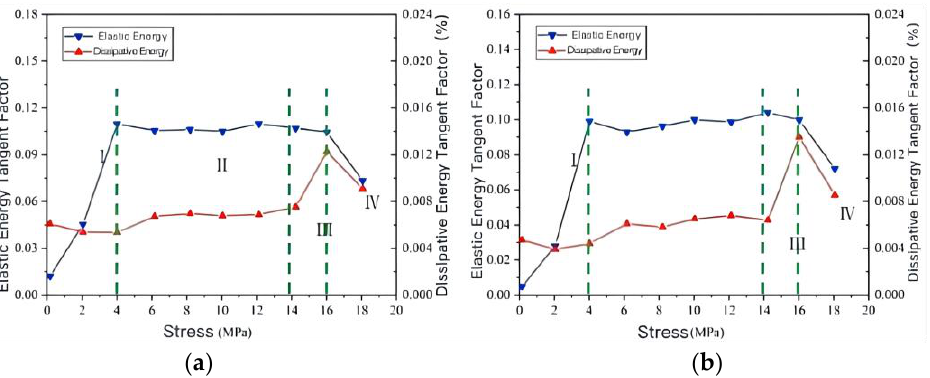
Figure 9. The energy tangent factor during grading cyclic loading/unloading. ( a ) Elastic energy tangent factor and dissipative energy tangent factor of coal sample S1. ( b ) Elastic energy tangent factor and dissipative energy tangent factor of coal sample S2.